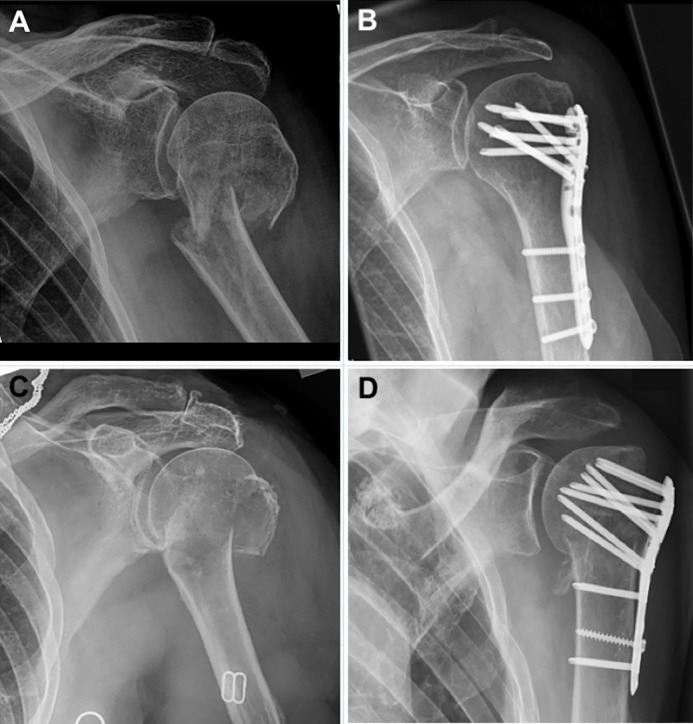
AO 11-A3 fractures before and after ORIF by locking plate.(A)+(B): fracture of a 69 years old female with postoperative anatomical fracture reduction = Inclusion criteria. (C)+(D): fracture of a 72 years old female with postoperative varus malreduction of the humeral head = Exclusion criteria.